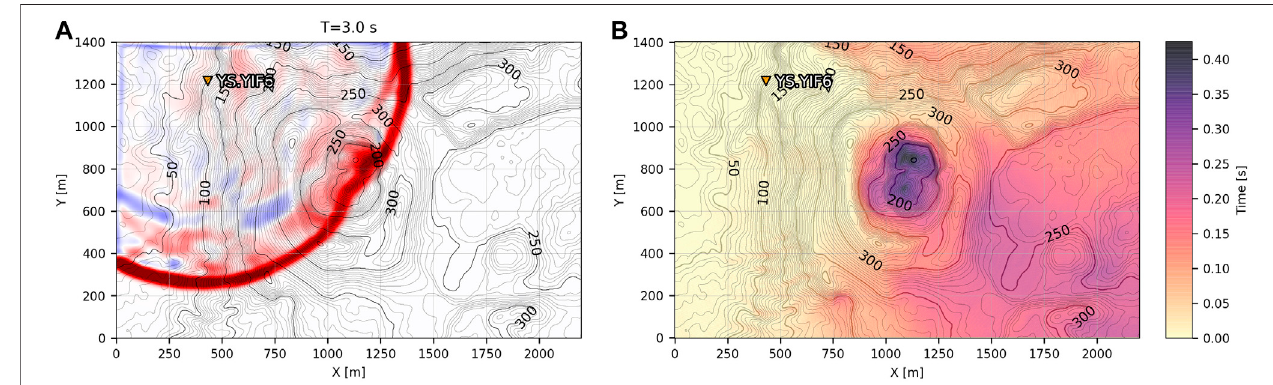
FIGURE 2 | Infrasound propagation at Yasur. (A) FDTD simulation snapshot at 3.0 s from station YIF6 propagating out across the study region. Red indicates a positive pressure (compression) while blue indicates a negative pressure (rarefaction) of the propagating acoustic wave at the ground surface. (B) Travel time difference between the FDTD calculation and straight-line propagation paths for station YIF6 across the grid. The straight-line propagation notably underestimates the travel time within the crater and the far side of the volcanic edi fi ce. Elevation contour lines are labeled in 50 m increments.